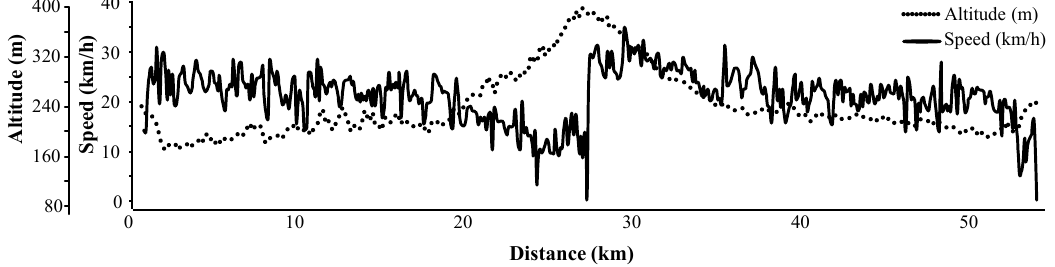
Figure 5. Profile of the physical exercise (bicycle riding) performed to evaluate the differences between anthropometric and biochemical parameters.